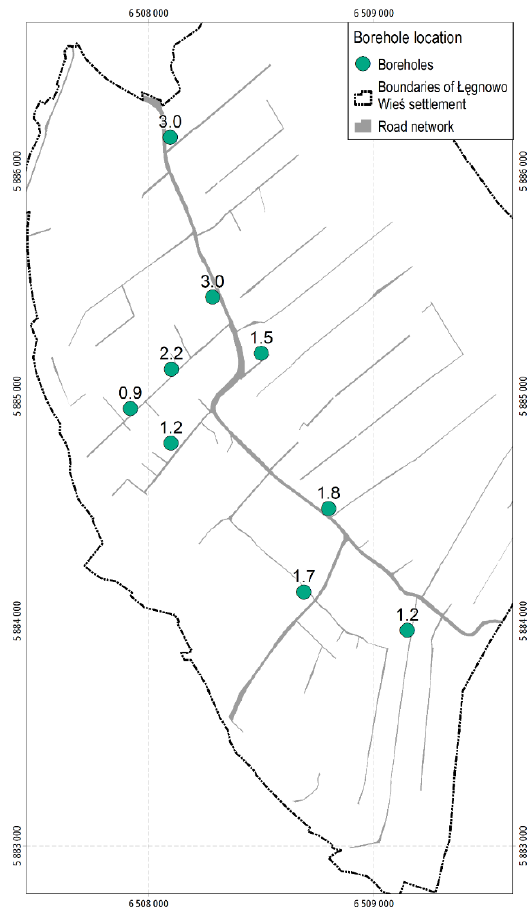
Figure 4. Location of boreholes in the residential development area of ŁWS (the number above the marked borehole means a soil sampling depth).